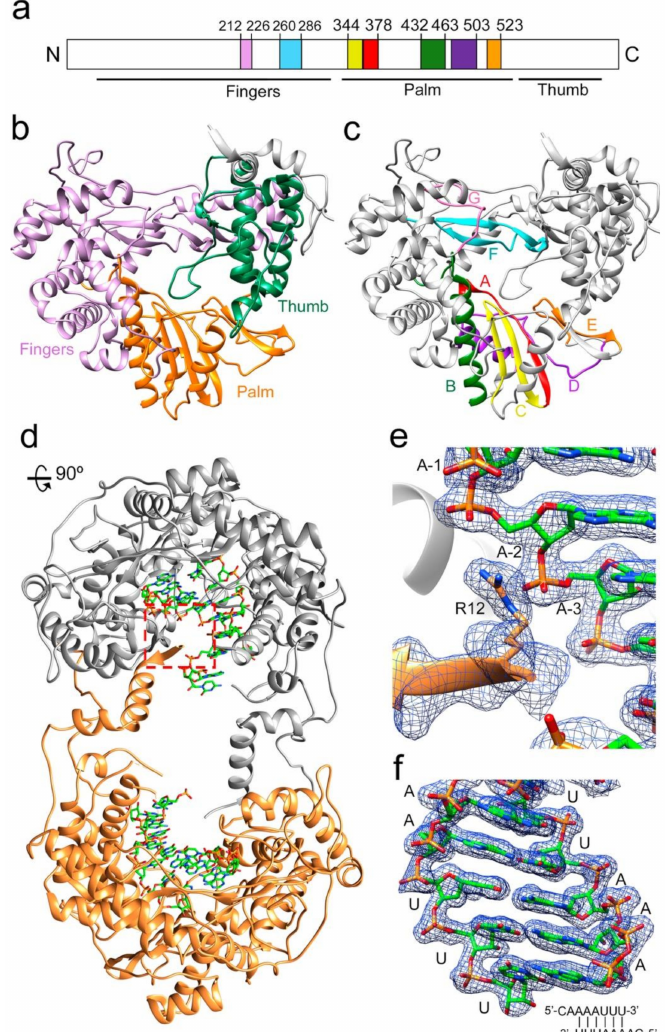
Figure 1. Structure of the TaV RdRP and RdRP-RNA dimers. ( a ) linear representation of TaV pol subdomains (fingers, palm and thumb) and conserved structural motifs. Each motif is highlighted in different colors: G (pink) F (cyan), A(red), B (green), C (yellow), D (purple) and E (orange). ( b ) Ribbon diagram showing the overall architecture of the TaV RdRP with the finger, palm and thumb subdomains shown in different colors: fingers (violet), palm (orange) and thumb (green). ( c ) Ribbon diagram of the TaV enzyme showing the seven conserved motifs colored as in a. ( d ) The TaV RdRP-RNA dimers. The two associated molecules are shown as ribbons in grey and orange, respectively. Amino acids at the N- and C-terminal ends are responsible for stabilizing the dimeric structure of the enzyme that is maintained in all ∆ 10-TaV pol ∆ 607-624-RNA complexes analyzed. The RNA molecules bound to each subunit are shown as sticks in the atom type color: C, green; P, orange; O, red; N, blue. ( e ) Close-up of the squared region highlighting the interactions established between the N-terminal residue R12 of one molecule (orange) with the phosphates at positions -2 and -3 of the RNA template bound to the second RdRP molecule. The 2Fo-Fc electron density map around the region is displayed at a contour of 1.5 σ (blue mesh). ( f ) The 2Fo-Fc electron density map shown around the dsRNA molecule. The sequence of the template-primer RNA is schematically represented at the panel